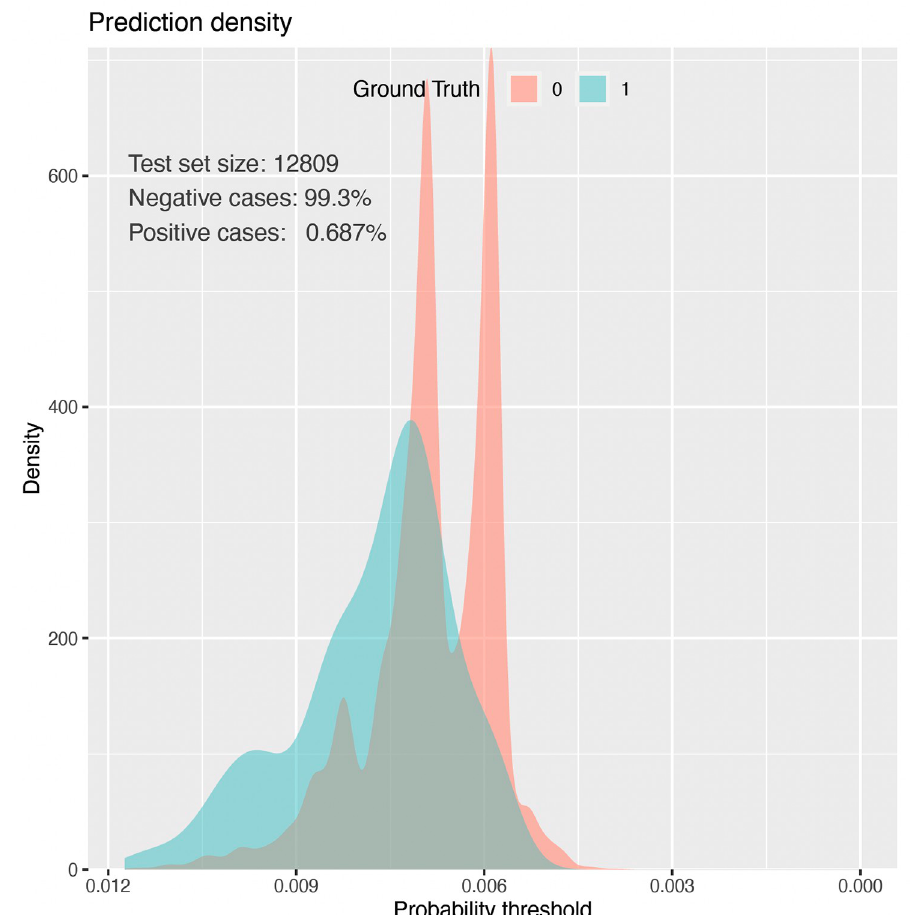
Fig 5. The prediction density graph for the Model II (elastic net). This graph presents how well the model discriminates the patients revised for dislocation (blue) from patients not revised for dislocation (red). In an ideal model the blue and red parts would be completely